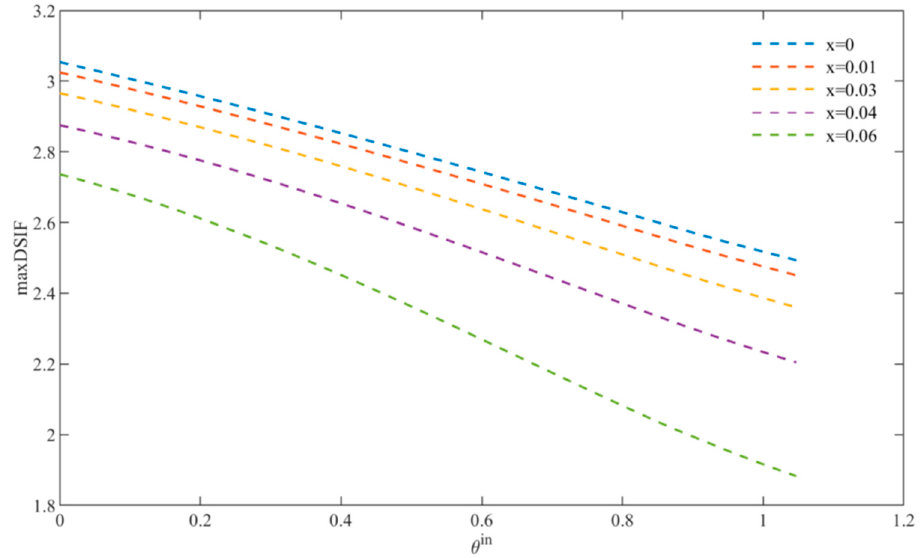
Figure 9. Variation of DSCF with incident angle.